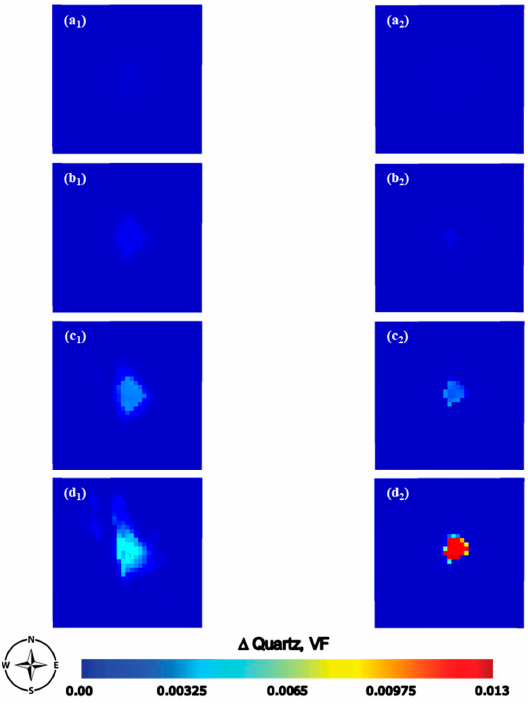
Figure A5. Plan view diagrams illustrating the simulated ∆ quartz volume fraction evolution for the base case from the arkosic layer top view ( a 1 , b 1 , c 1 , d 1 ) and homogenous case from the Upper Mt. Simon top view ( a 2 , b 2 , c 2 , d 2 ) at ( a ) 30 years, ( b ) 100 years, ( c ) 1000 years, and ( d ) 10,000 years. Each figure’s size is 35 km × 35 km (x, y).